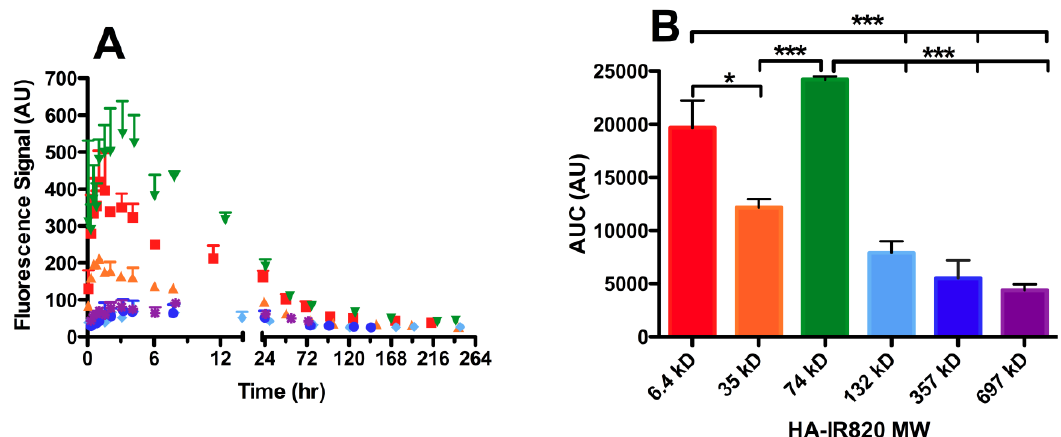
Figure 5. Lymphatic drainage to the axillary lymph node package of different MW HA-IR820 conjugates after s.c. administration. Increased lymphatic uptake of the 74-kDa HA-IR820 conjugate into the axillary lymph node package is evident in the ( A ) time vs. fluorescent signal and ( B ) area under the curve (AUC) vs. each HA-IR820 MW conjugate bar graph. The MW distribution trends shown are representative of the trends observed for all three lymph nodes (axillary, popliteal, and iliac lymph nodes) visualized after imaging mice on their right sides post HA-IR820 administration (mean ± SEM, * p < 0.05, *** p < 0.0001).